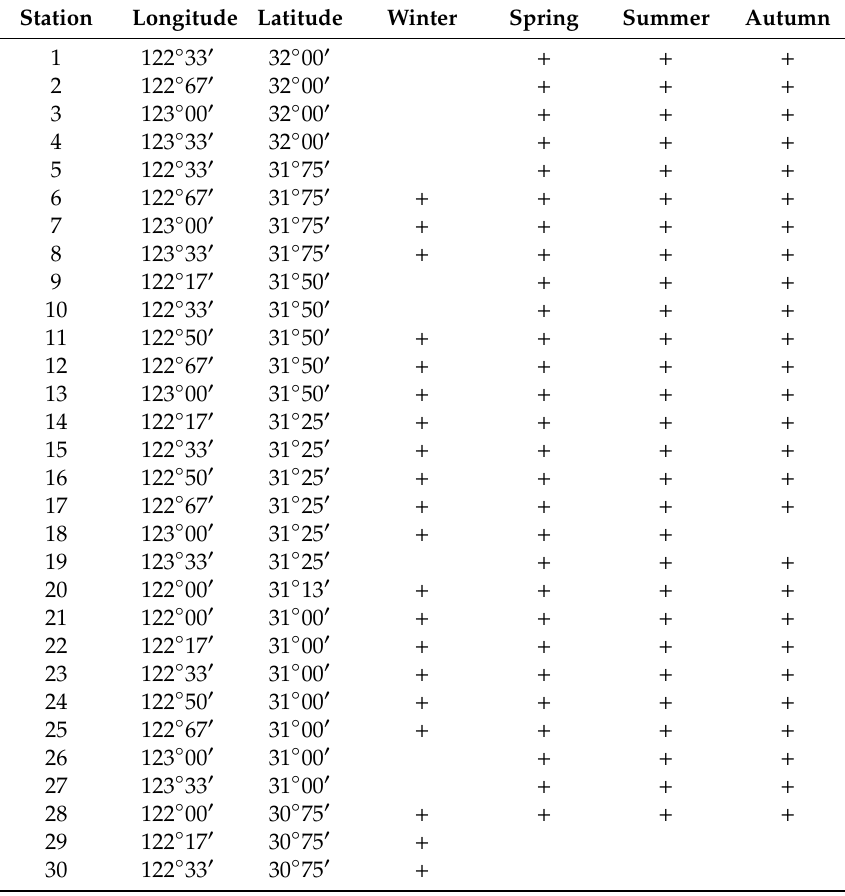
Table 1. Sampling sites coordinates (“ + ” represents the station fetched on each